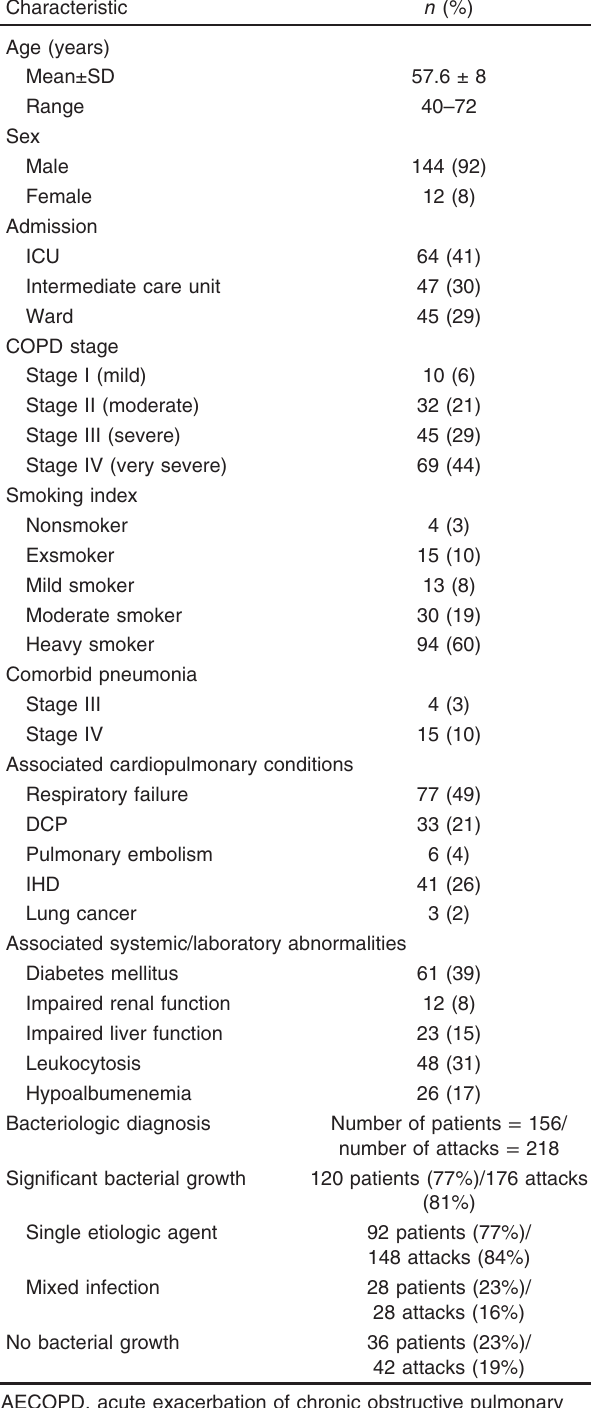
Table 1 Demographic and clinical characteristics of patients with AECOPD ( n = 156)